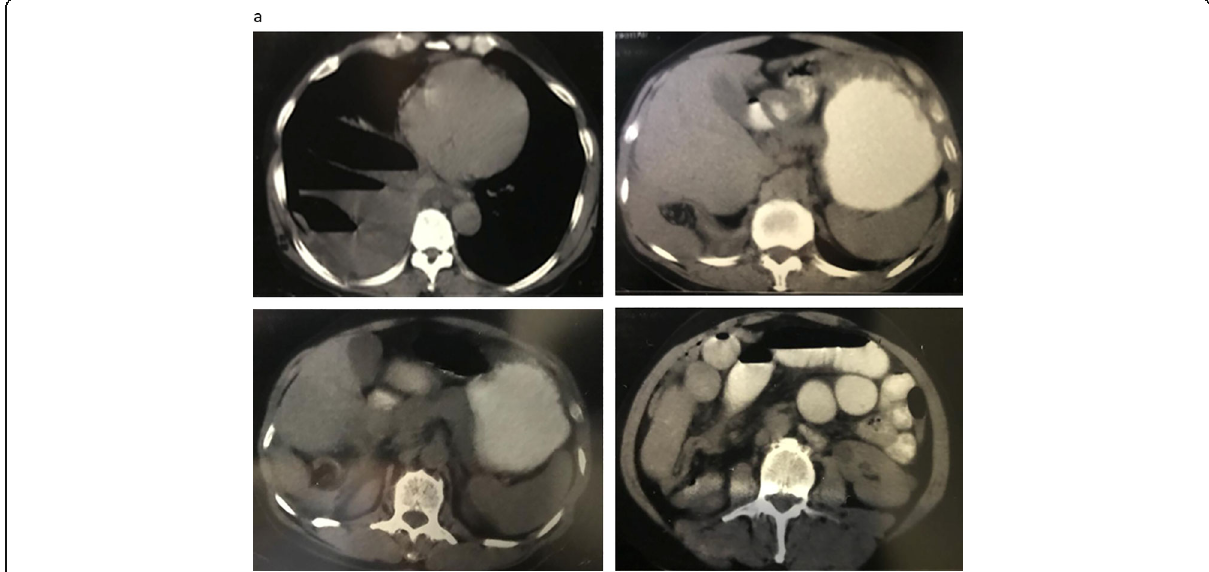
Fig. 3 CT scan of patient showing air-fluid level in the intestine, presence of intestinal loop behind the liver through right hemidiaphragm into the right